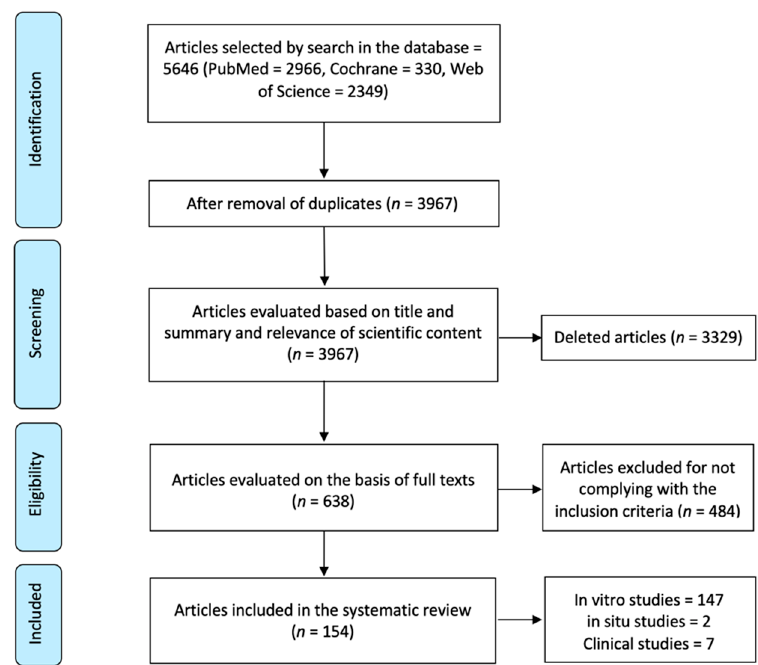
Figure 1. Flowchart of the selection process of the studies.